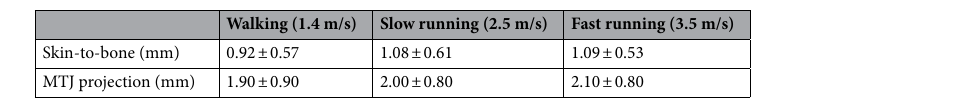
Table 2. Contribution of skin-to-bone displacement and projection of MTJ to the skin surface on the AT length as means of the root mean square error (average value ± standard